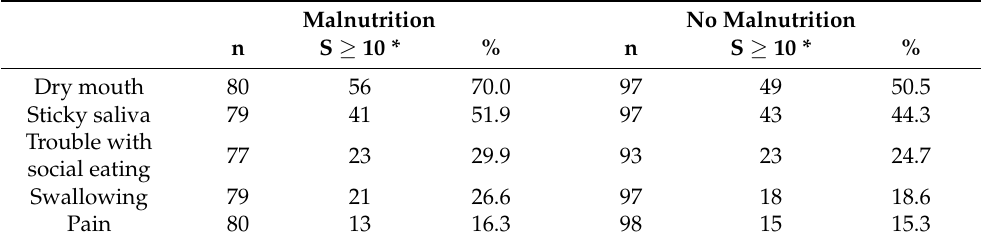
* S ≥ 10: Number of patients reporting scores from the EORTC QLQ-H&N35 European Organization for Research and Treatment of Cancer Quality of Life Questionnaire-Head and Neck 35 at one year after the termination of treatment of at least 10 points higher compared to the score reported at the start of treatment, indicating a clinically relevant deterioration of the